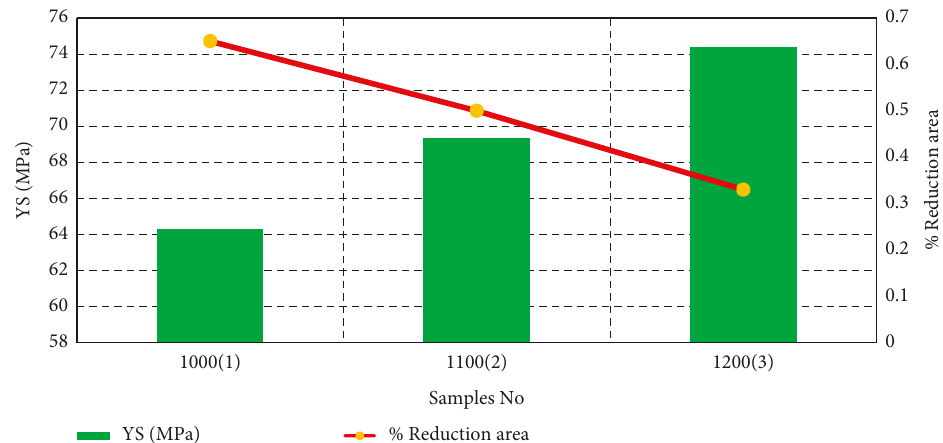
Figure 18: Samples vs. yield strength (MPa) and % reduction